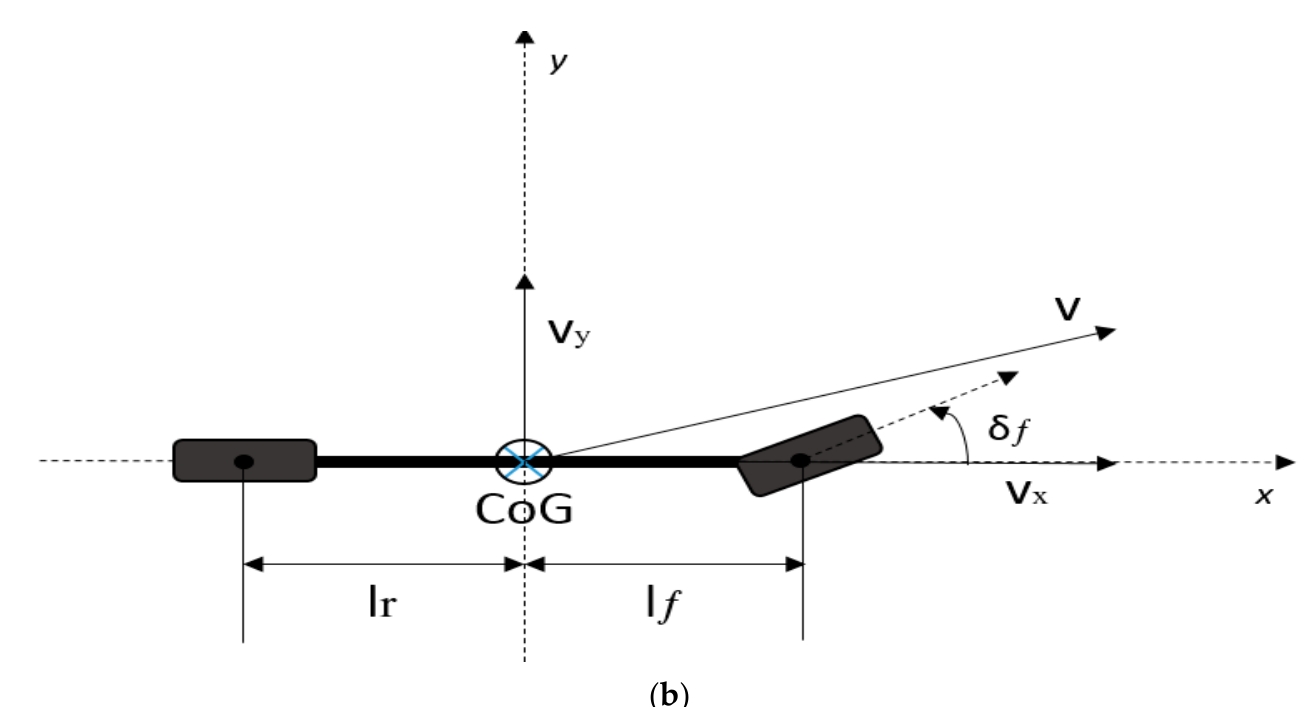
Figure 1. The AV schematic ( a ) internal representation ( b ) a bicycle model. The vision system provides the information related to the road as seen in Figure 2; here y L represents the lateral variation. The distance between the object and the road centerline point is described by the radius R L . K L stands for the road fluctuation, which is represented by the road radius reciprocal as ‘ K L = 1/ R L ’. The angle within the road tangent and the orientation of AV is represented by ε L . The look-ahead vision system distance is represented as L . The AV model in the state form is represented by the following dynamic equations [41,42]: